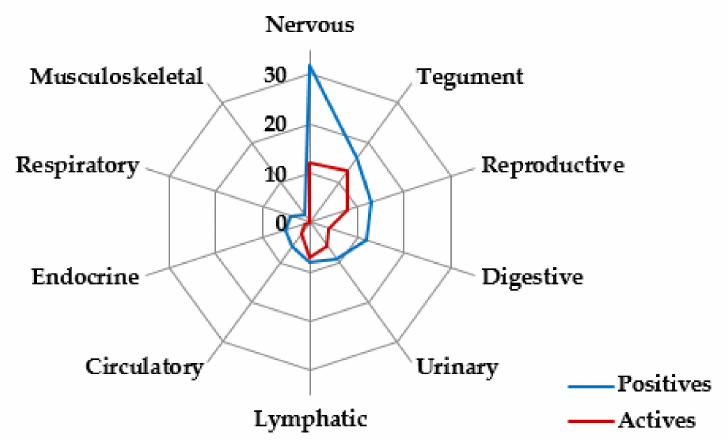
Figure 4. HV active replication in tissues of each organ system. Tissues positive for both HV DNA and GAPDH RNA were defined as the total set of positive tissues (“positives”), and the number of these positive tissues containing HV RNA was determined (“actives”). This provided an indicator of active replication. The results are shown for different organ